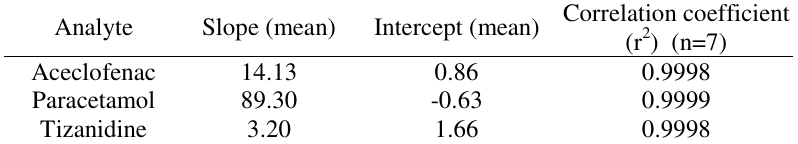
Table 2. Results of linearity.